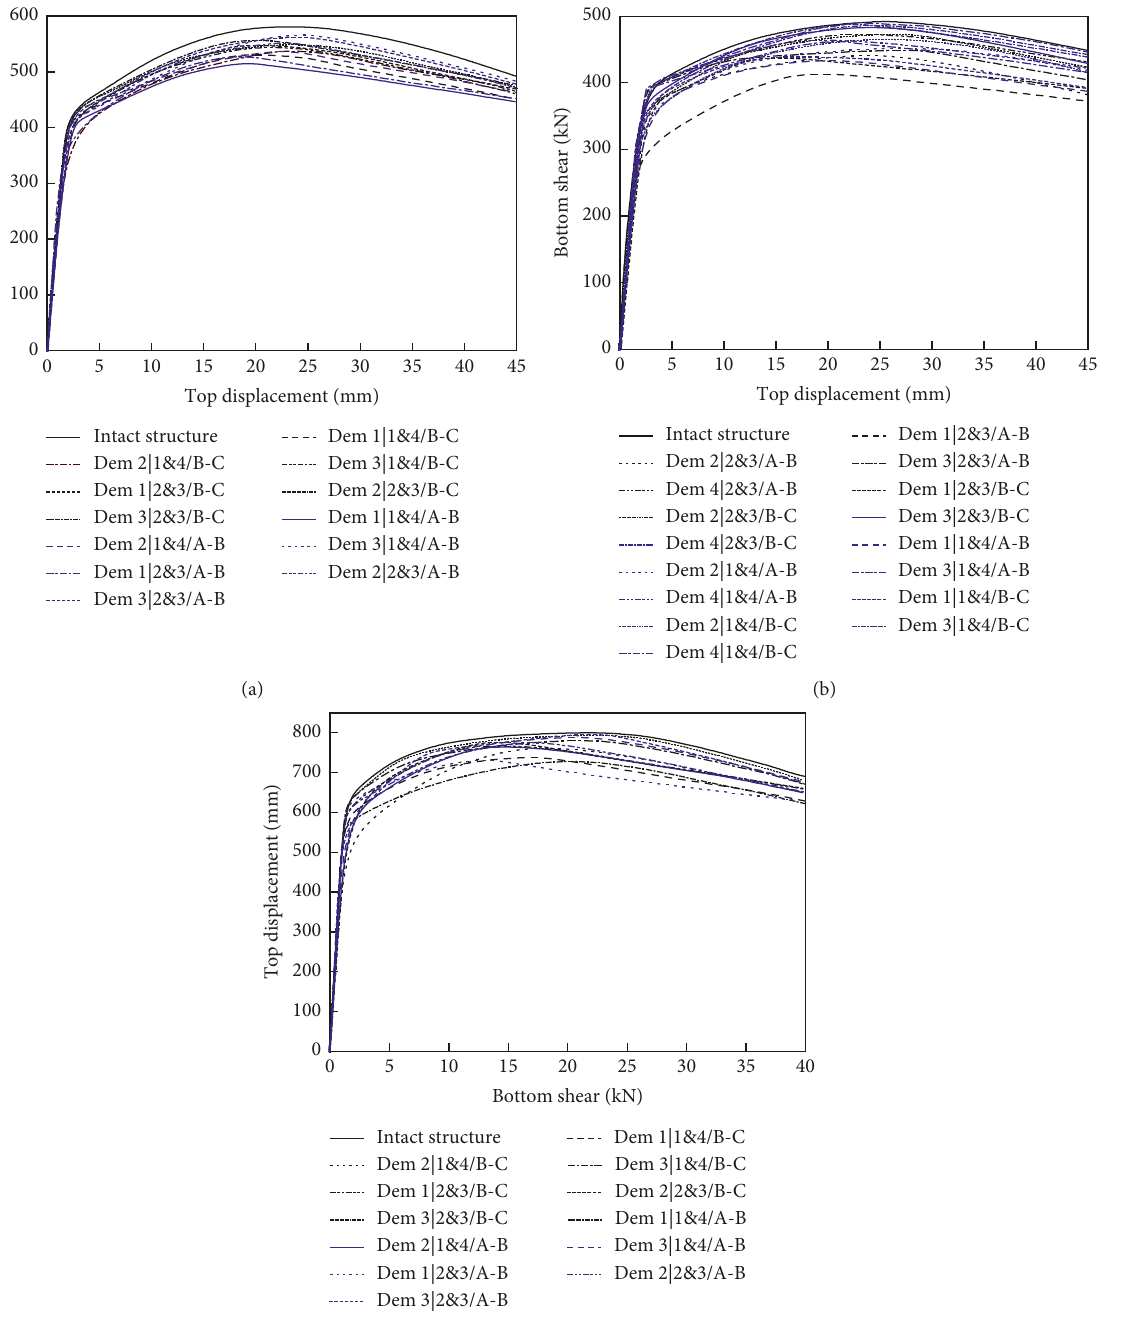
Figure 4: Bottom shear-top displacement curve. (a) Model: MAS3-7 (0.1 g). (b) Model:MAS4-7 (0.1g). (c) Model:MAS3-8